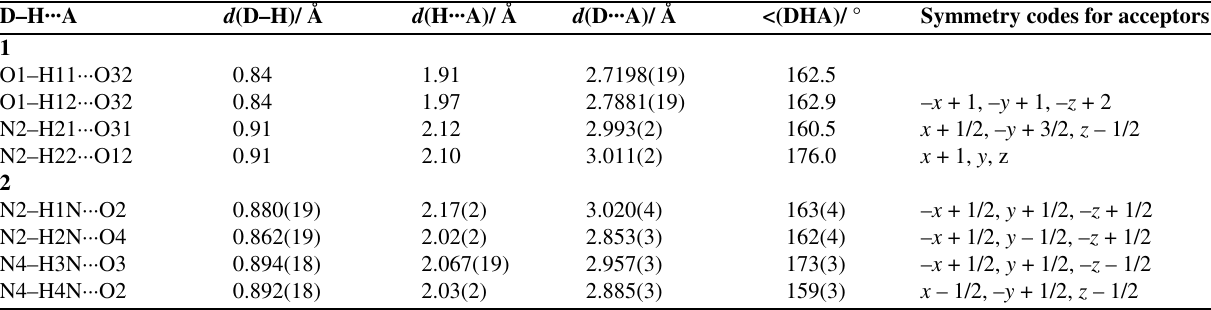
Table 2. Hydrogen bonding geometry for 1 and 2 .